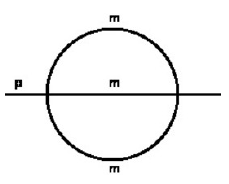
Figure 4. Massive